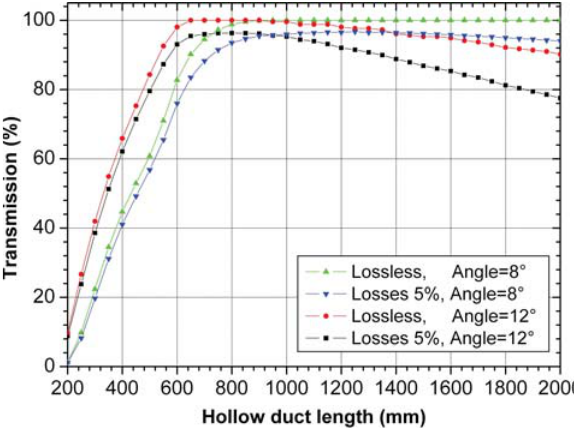
Fig. 4. Comparison of hollow-duct transmission curves if reflec- tion losses from the waveguide sidewalls are / are-not taken into account. Performed for two selected laser-diode emission angles ϕ in simplified 2D Matlab model